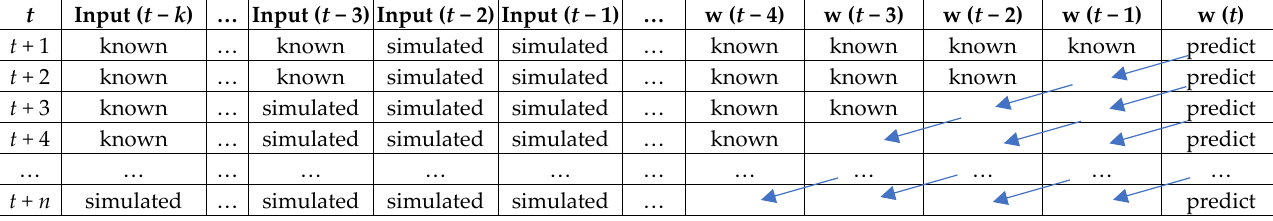
Table 1. Concept of WFS.